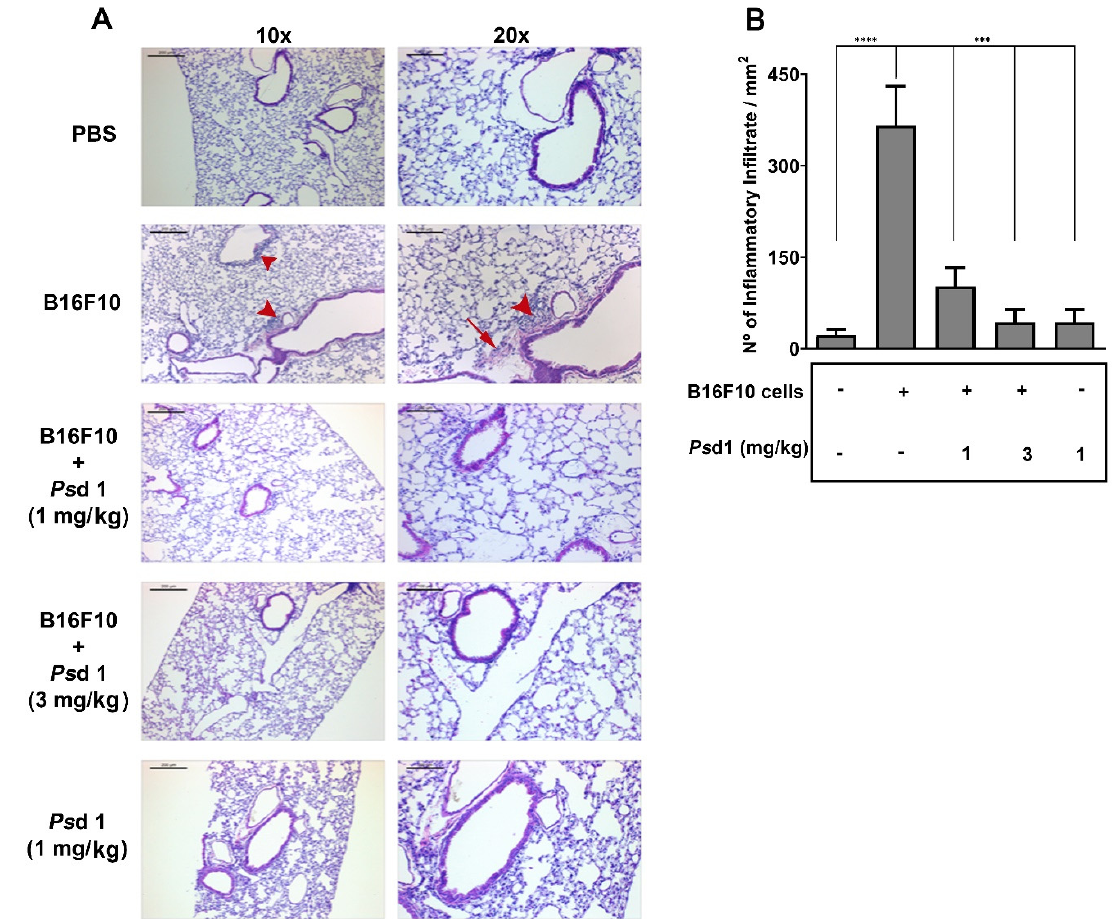
Figure 7. Ps d1 inhibited the appearance of inflammatory cells in lung tissues. Two animals from each group of the in vivo experiment were anaesthetized and submitted to transcardial perfusion for further histological procedures. The lungs were removed and prepared for hematoxylin and eosin (HE) staining as described in the Materials and Methods. ( A ) Representative images from the lungs of one animal from each experimental group. Animals injected with just B16F10 cells showed the presence of infiltrating cells around blood vessels (red head arrows) and fibrotic lesions (red arrow) compared to animals from the other groups. The left and right panels indicate 10 × and 20 × magnifications, and the bars represent 200 and 100 µ M, respectively. ( B ) Quantification of inflammatory infiltration ( ± SEM) was obtained in six fields, corresponding to 90% of the tissue. A significant reduction in inflammatory cells was observed in animals treated with Ps d1. **** p < 0.0001 for B16F10 vs. PBS or *** p < 0.001 forB16F10 vs. Ps d1 1 mg / kg or B16F10 vs. Ps d1 3 mg / kg or Ps d1 1 mg / kg alone. Values represent the mean ± SD of two independent experiments analyzed by one-way ANOVA and Bonferroni’s multiple comparison test.